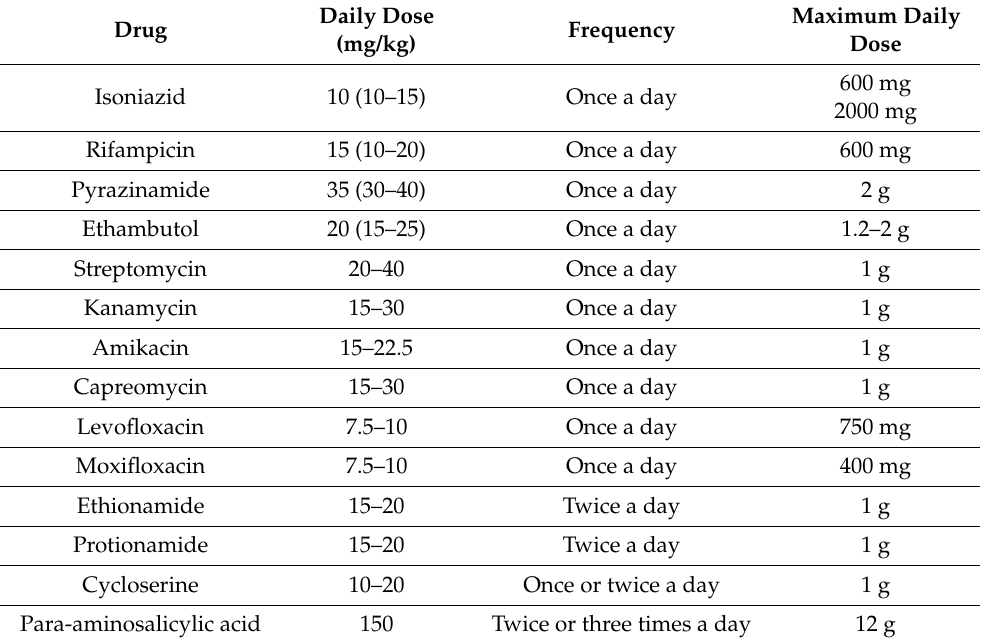
Phases of Chemotherapy Course Intensive Phase Continuation Phase 2 HR ZE 4 HR 3 RZE Km Lfx 6 RZE Lfx 8 Z Km (Cm) Lfx Pto Cs 12 Z Lfx Pto Cs (PAS) (PAS) 6 Bdq 8 Z Km 16 Z Pto Cs PAS (Cm) Pto Cs PAS 8 Z Cm Lfx Pto Cs PAS 16 Z Lfx Pto Cs PAS 6 Bdq Cm Lzd PAS 18 Mfx Lzd PAS Im/Cln Amx/clv Amx/clv